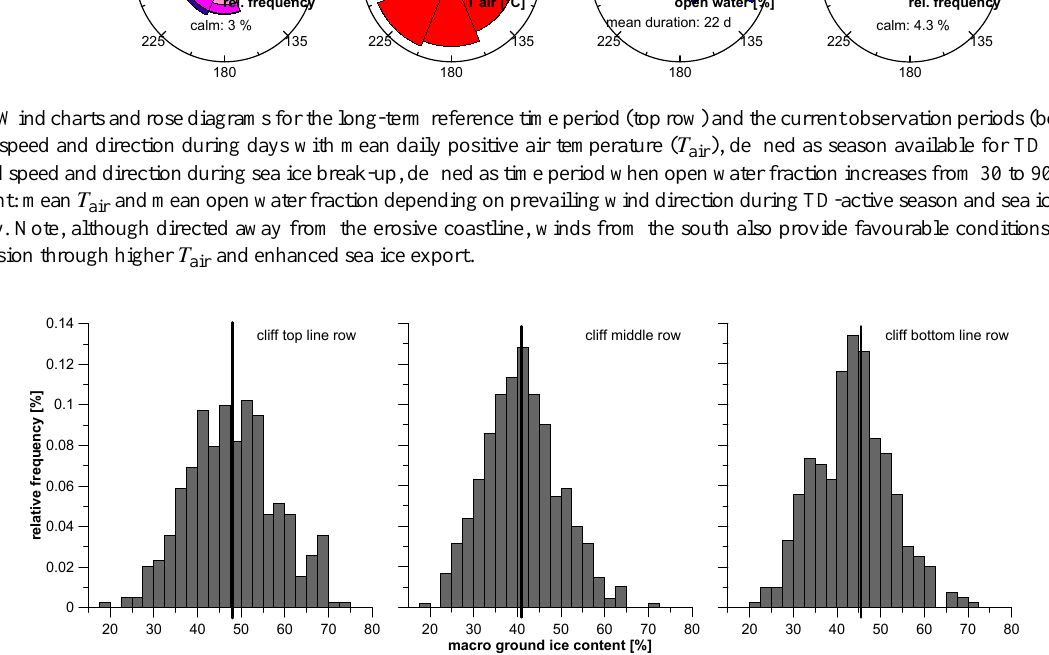
Figure 21. Histograms of macro ground ice content along erosive coastal cliffs on Muostakh Island. Classification of ice-wedge polygons into three different vertical positions shows shift towards higher macro ground ice contents for the lower and upper parts of the subsurface. Vertical lines indicate mean